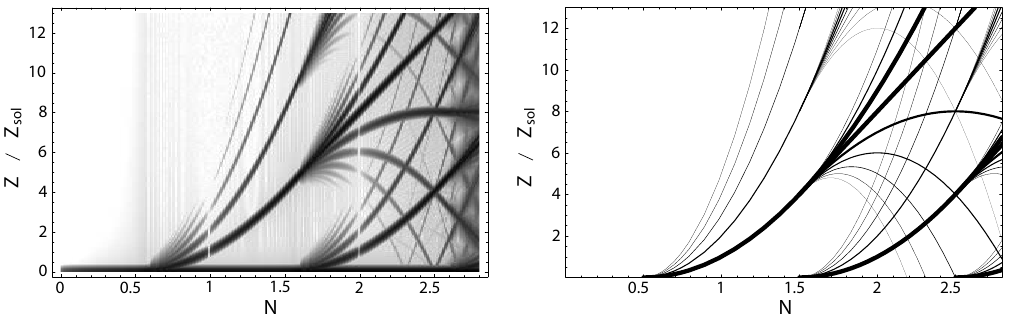
Figure 11. (Left) Soliton radiation beat analysis (SRBA) chart from repeated numerical simulations with increasing soliton number N ; (right) corresponding predictions of beat signals and its overtones (from